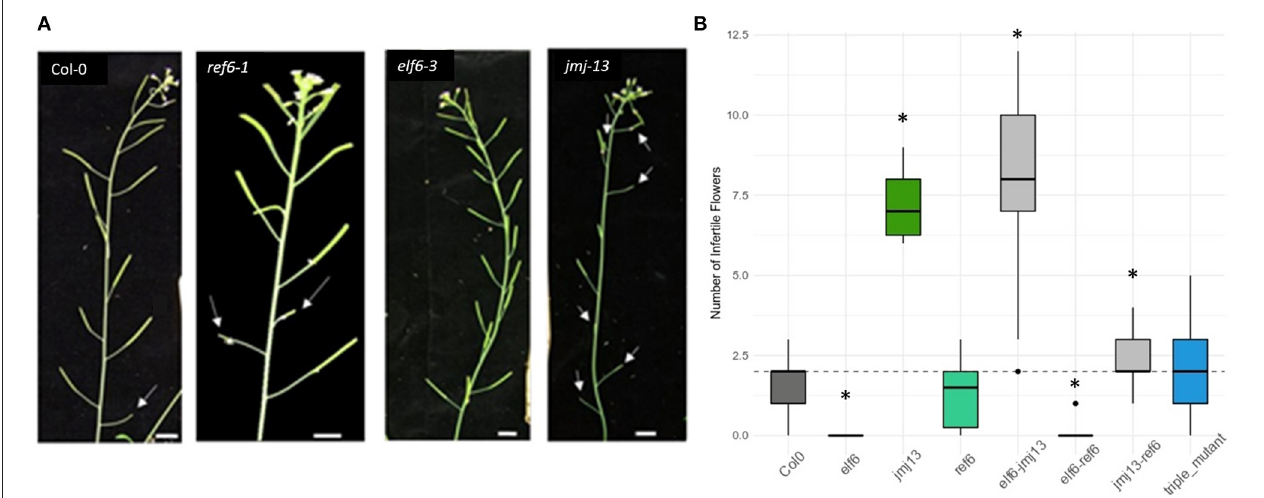
FIGURE 1 | Fertility phenotypes of H3K27me3 demethylase knock-out mutants. (A) Varying degrees of self-fertility in the demethylase knock-out mutants. The white arrow heads point to aborted siliques caused by failed self-pollination, as seen in the first flower of Col-0 and to the eighth flower of jmj13 . Scale bars represent 1cm. (B) Quantification of self-fertility. Numbers of aborted siliques are plotted with asterisks indicating which data point is statistically significant as compared to that of Col-0 ( p < 0.05, t -test). The dashed horizontal line represents the median y -axis value of